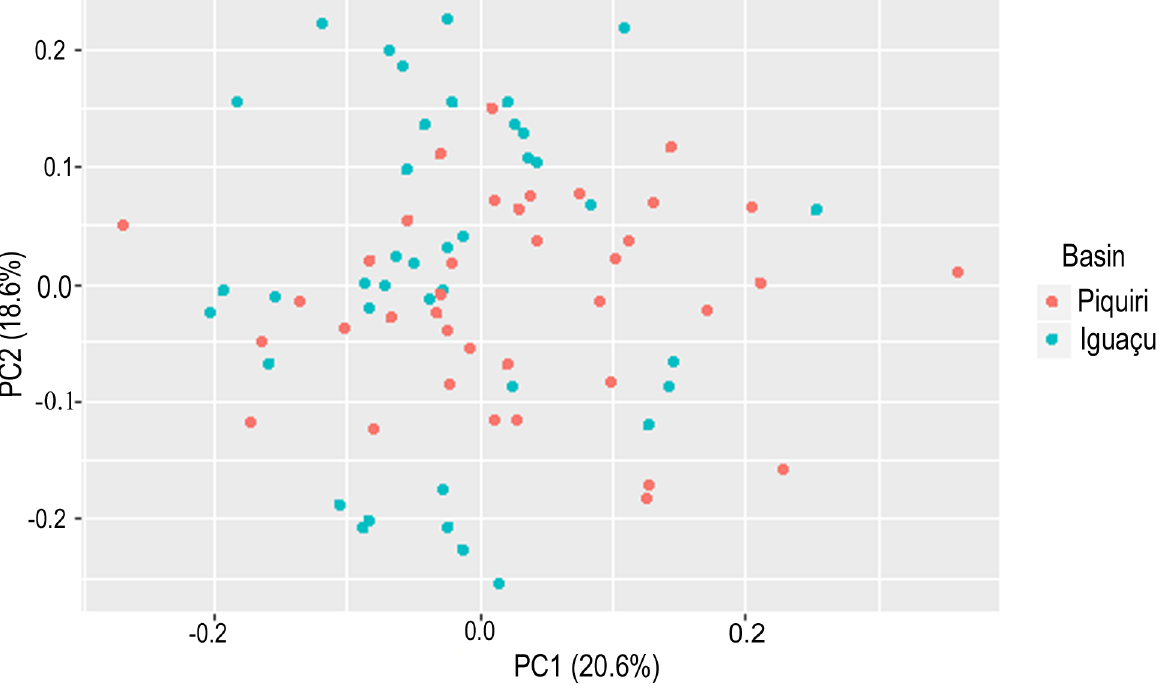
Figure 3. Ordination of populations of Astyanax bifasciatus in lower Iguaçu and Piquiri river basins, Paraná, Brazil, produced by the first two axes of the principal component’s analysis (PCA 1 and PCA 2) applied to the correlation of 16 morphometric and meristic data of the specimens (based on percentage of standard length and percentage of head